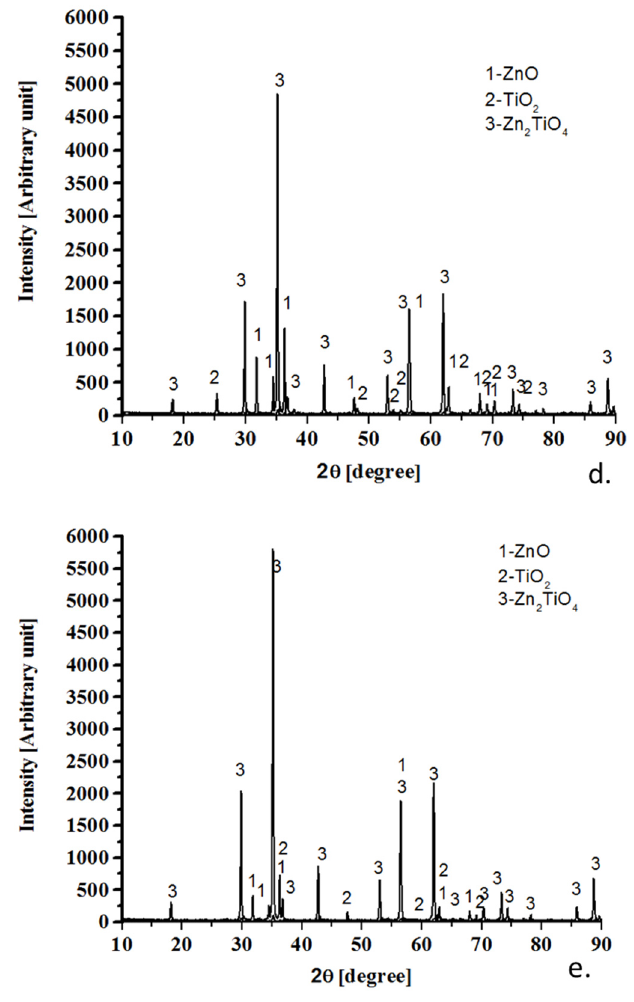
Figure 3. X-ray diffraction (XRD) patterns of synthetized composites: ( a ) ZT-300, ( b ) ZT-500, ( c ) ZT-600, ( d ) ZT-700, ( e ) ZT-800.